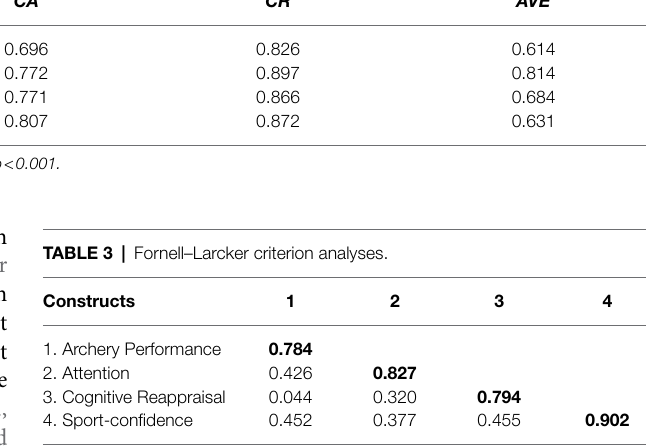
TABLE 2 | Reliability tests and validity tests of the measurement model. Constructs Loadings range Archery Performance